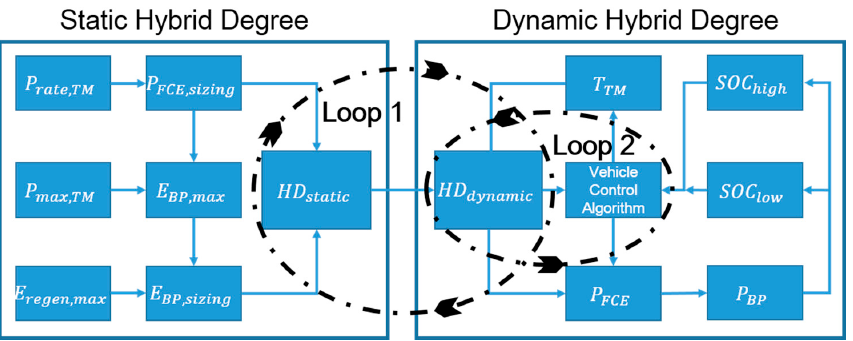
Figure 4. Testing flowchart with two loops for system sizing design and vehicle control algorithm design in the defined application.